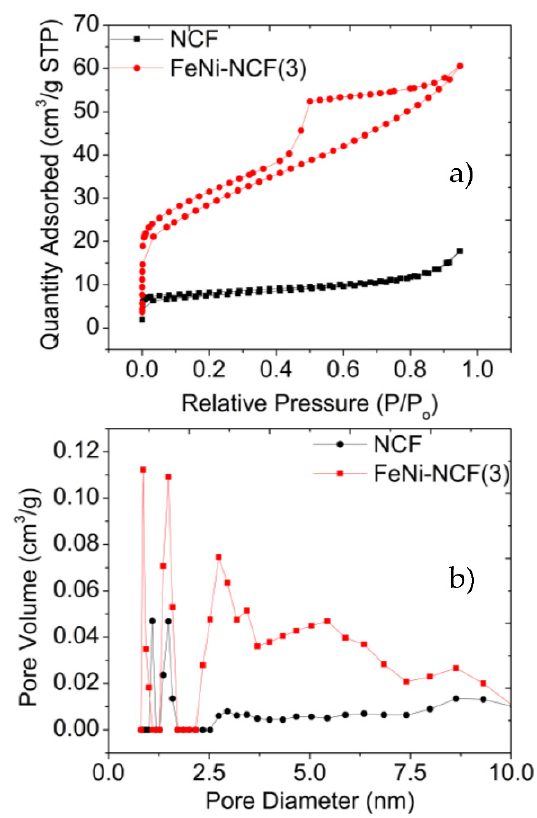
Figure 2. ( a ) N 2 sorption isotherms and ( b ) the corresponding pore size distributions of NCF and FeNi-NCF(3).